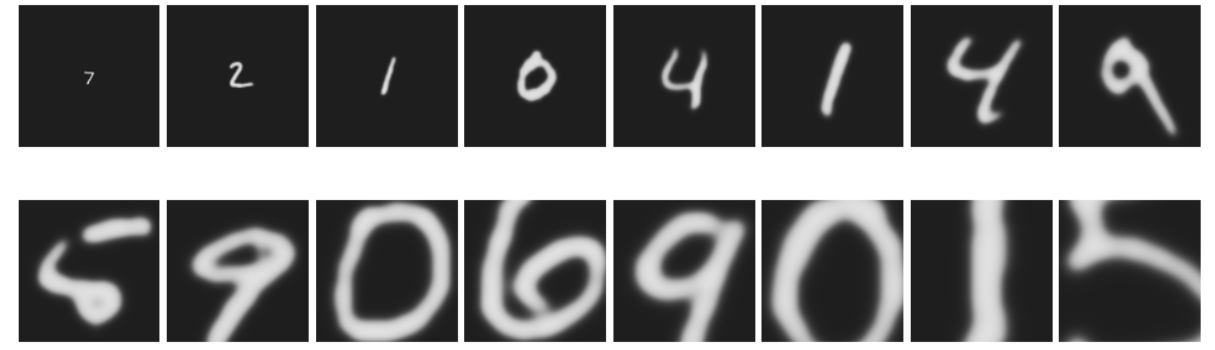
Figure 5. Instances of MNIST Large-Scale dataset.